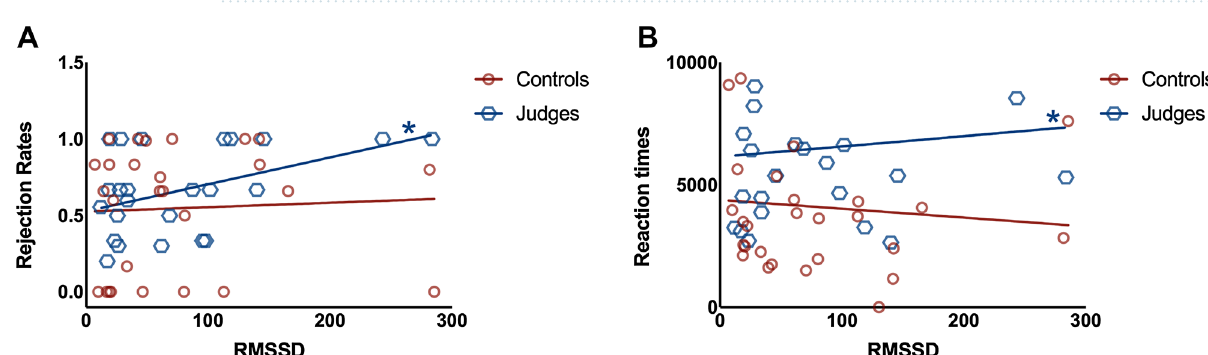
Figure 2. Panel ( A ) shows a group comparison of rejection of unfair offerings in comparative and individual rounds. Panel ( B ) exhibits a group comparison of reaction times in rejected trials between rounds. An Asterix reveals significant group comparisons ( p < 0.05).